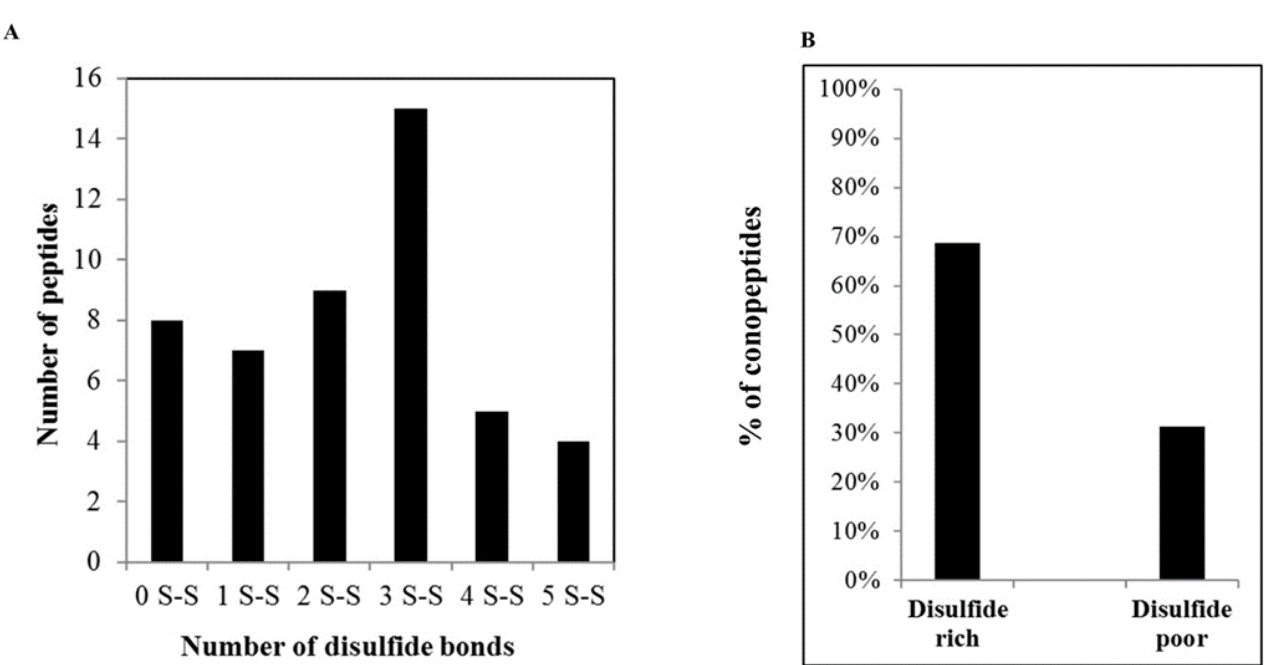
Figure 4. Number of disulfide bridges determined based on the mass shift detected by LC/MS after reduction/alkylation of Cys residues.